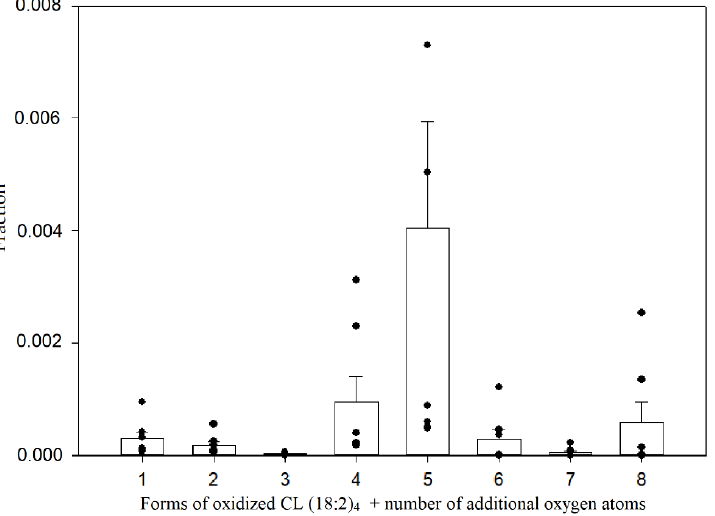
Figure 7. Relative amounts of oxidized tetralinoleoyl cardiolipin species in control mitochondria. The relative quantification was computed by calculating the fraction of the integrated peak area by the total peak area of all observed oxidized and non-oxidized tetralinoleoyl cardiolipin species; ( n = 7, dots represent values of each experiment, mean ± standard error).